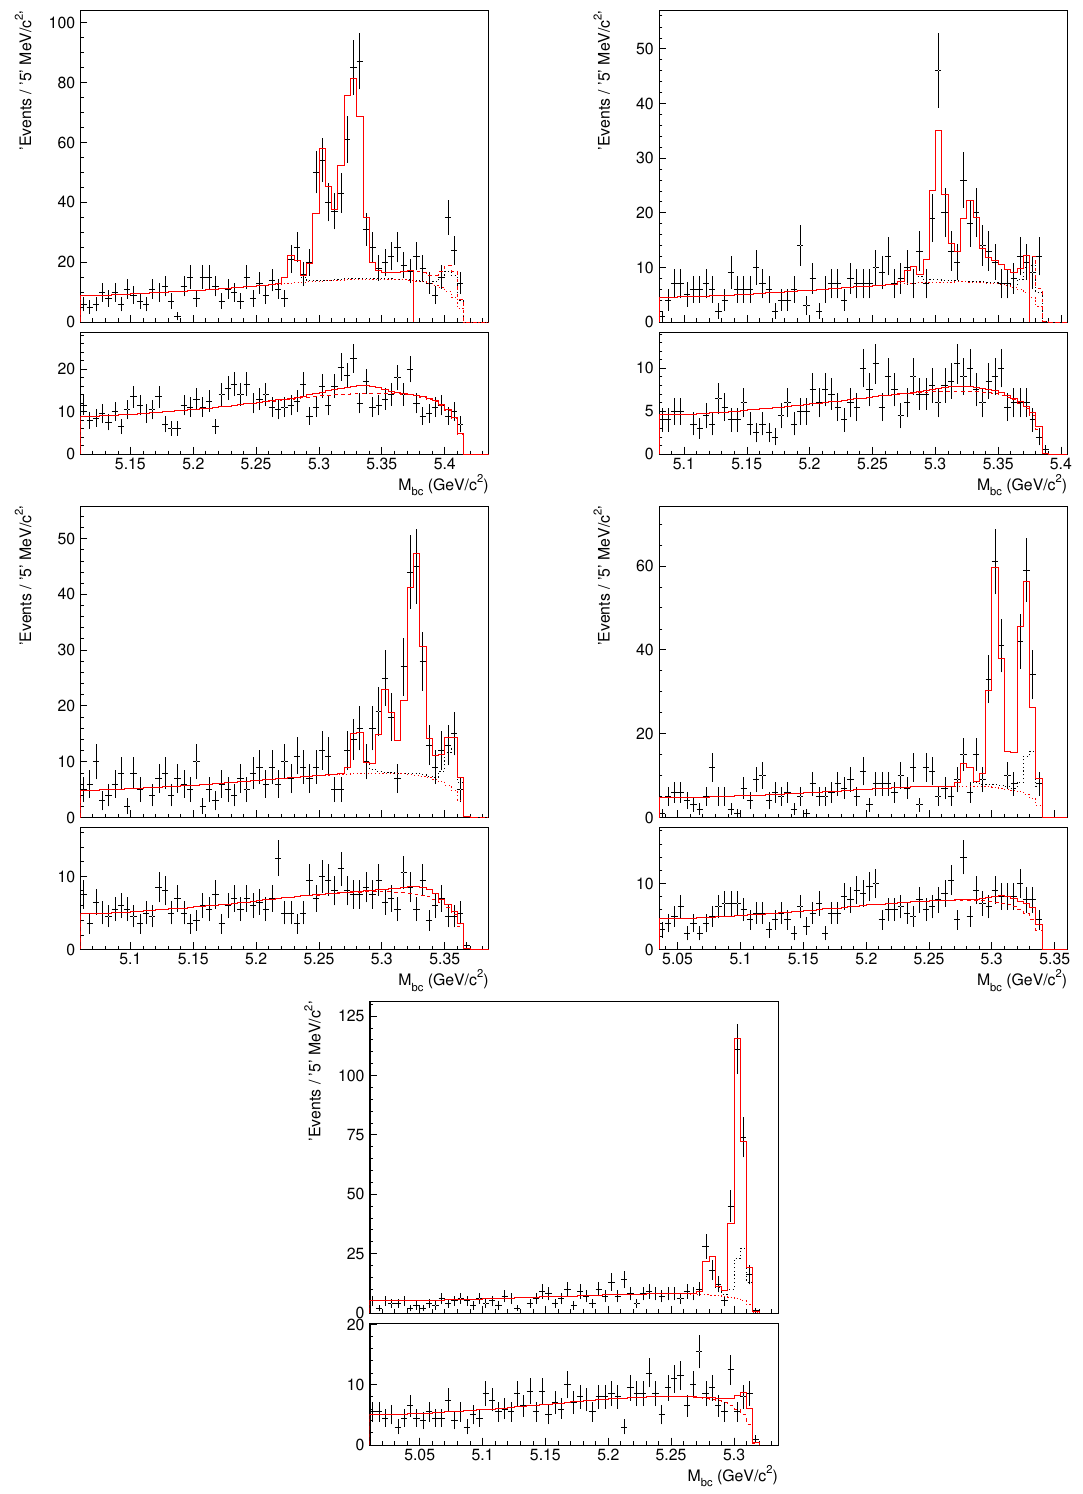
Figure 17 . The M bc distributions for the points 19 to 23 in table 5 (from left to right and from top to bottom). Legend is the same as in figure